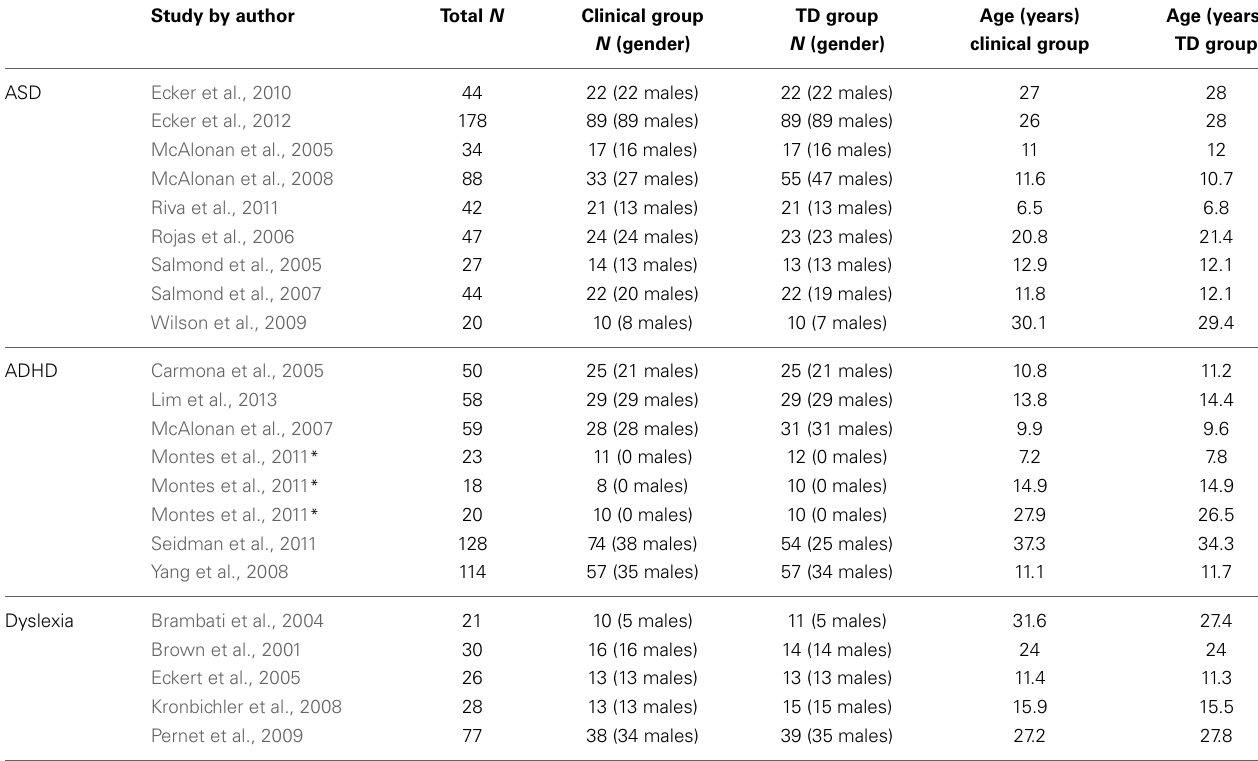
Table 2 | Studies included in the cerebellar ROI